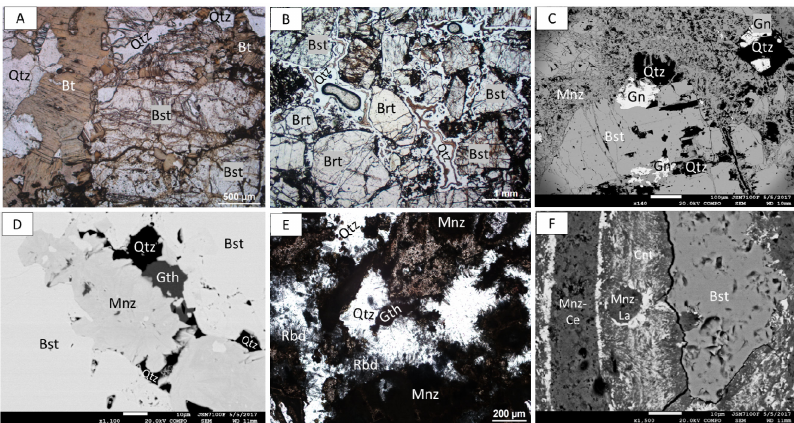
Figure 11. Thin-section optical and SEM photographs of representative samples displaying the mineralogical assemblages: ( A ) KIV sample: Bastnaesite (Bst) crystals are affected by a dense network of monazite (Mnz) and quartz (Qtz); Biotite (Bt) forms large brown crystals with perfect cleavage ( B ) GASH sample: Breccia consisting of clasts of bastnaesite, barite (Brt) and quartz.; ( C ) MASE sample: Galena (Gn) in quartz associated with bastnaesite and monazite (Mnz); ( D ) NYARU sample: Microvein + replacement of bastnaesite by monazite together with quartz and goethite; ( E ) Acicular crystals of rhabdophane (Rbd) form around quartz and replace bastnaesite and monazite. ( F ) GASA sample: Cerianite (Cnt) grains locally replacing bastnaesite and/or monazite-(Ce); monazite-(La) grew during or after the cerianite rims. Mineral abbreviations (except Cnt and Rbd) according to [27,28]. As a summary, the mineralogical observations above, which are consistent with and complete the works of [17,29] are presented in a paragenetic sequence (Figure 12).